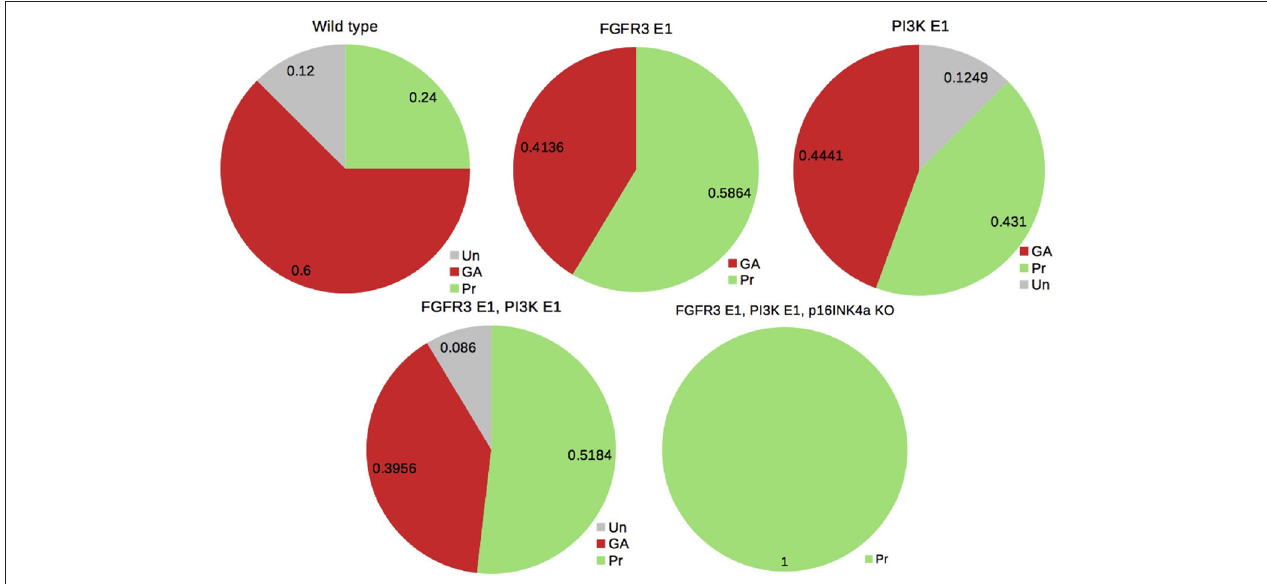
FIGURE 5 | Probabilities of the phenotypes for the bladder tumourigenesis model in the wild type and mutant contexts: probabilities for the double mutant FGRF3 overexpression (FGFR3 E1) and PI3K overexpression (PI3K E1) suggest a slight advantage in mutating FGFR3 in a PI3K-mutated context (by increasing the probability of Proliferation); a third mutation of the tumor suppressor CDKN2A (coding for p16INKa) leads to the sole phenotype Proliferation (see Remy et al., 2015).